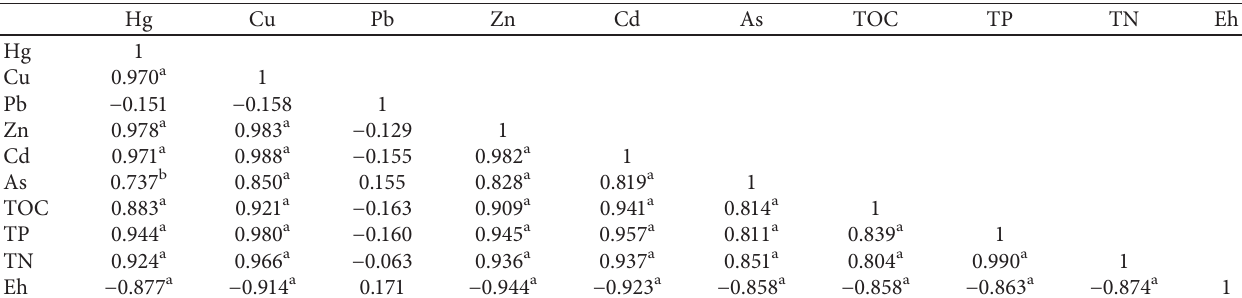
Table 9: Matrix of correlation coefficients among heavy metals and environmental factors in sediments of Jiuzhen Bay.